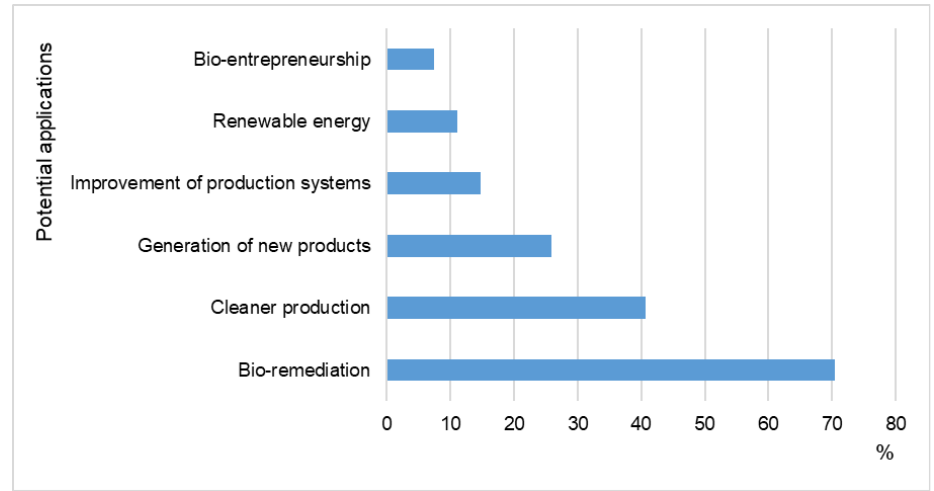
Figure 11. Potential applications of biotechnological processes perceived by the students.